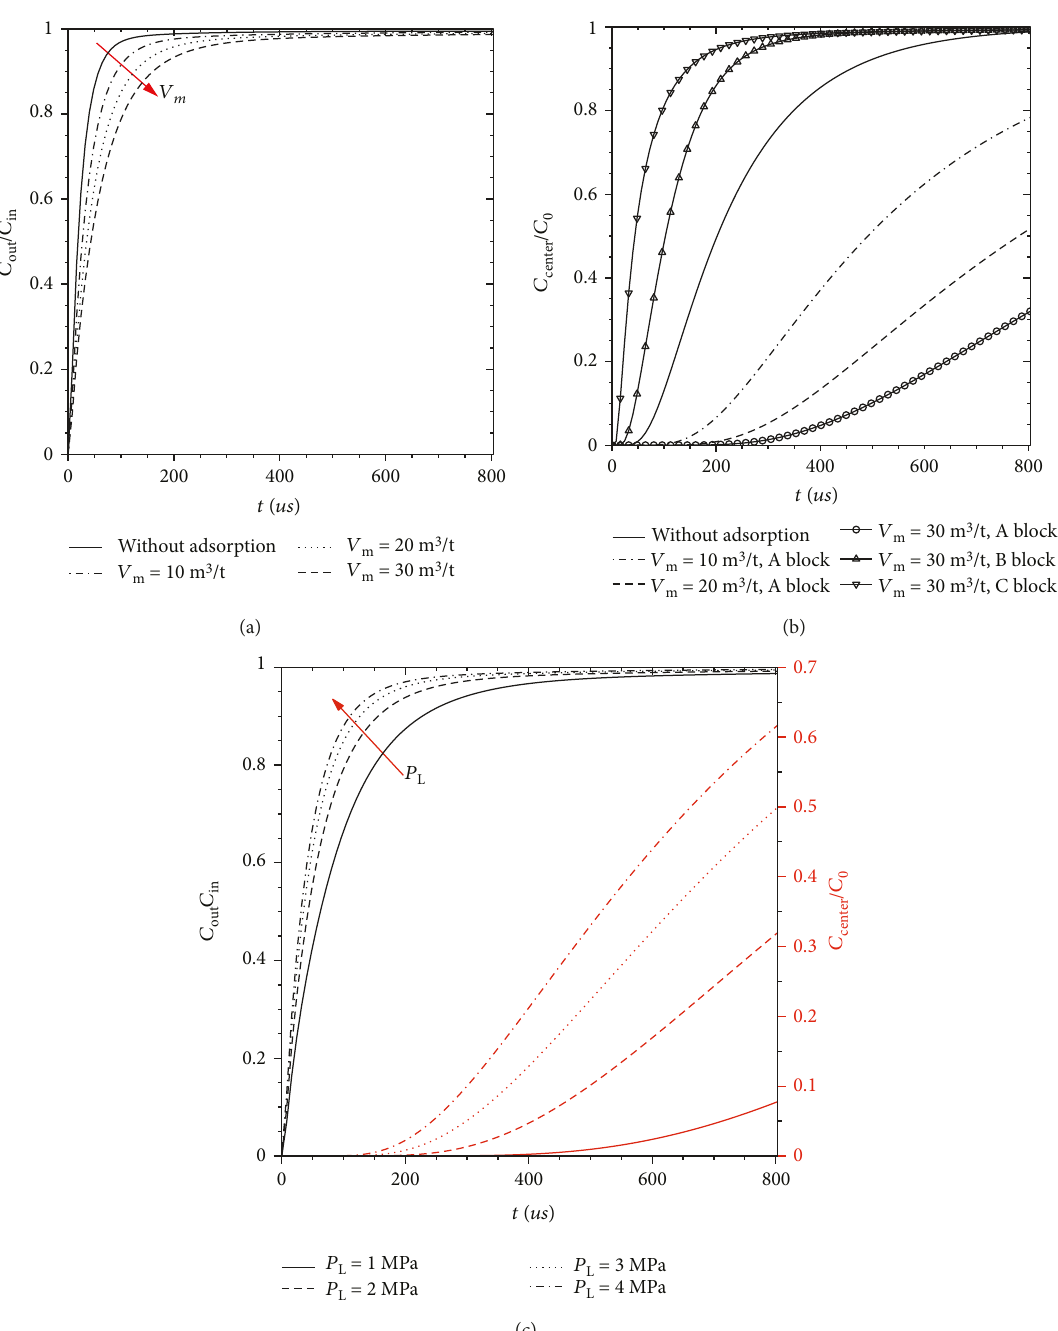
Figure 6: Concentration change over time. (a) Total concentration output at the outlet. (b) concentration through the center of blocks A, B, and C. (c) p L e ff ect; the red lines represent the corresponding central concentration of block